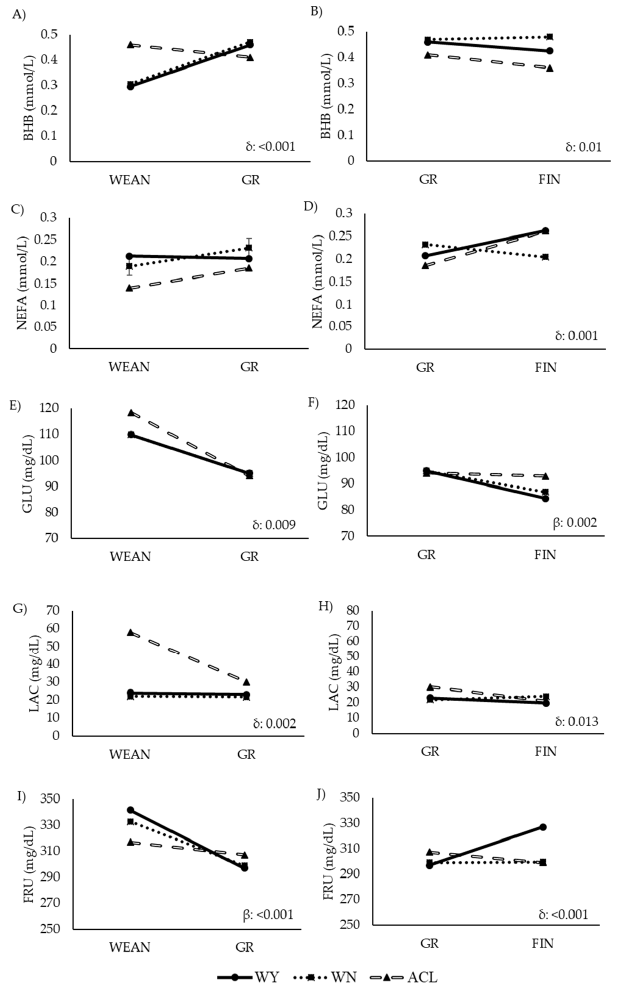
Figure 6. Comparison of levels of energy-related metabolites in steers at two time points during the fattening period (longitudinal approach). Abbreviations: ACL: crossbred animals Angus-by-Charolais or Angus-by-Limousin; BHB: β -hydroxybutyrate: Panels ( A,B ); FIN: finishing period; FRU: fructosamine: Panesl ( I,J ); GLU: glucose: Panels ( E,F ); GR: growing period; LAC: lactate: Panels ( G,H ); NEFA: non-esterified fatty acid: Panels ( C,D ); WEAN: after weaning; WN: Wangus animals (Wagyu-by-Angus); WY: fullblood Wagyu animals. Parameters are expressed with median values. β indicates significant effect of time; δ indicates significant effect of the interaction between breed and time.